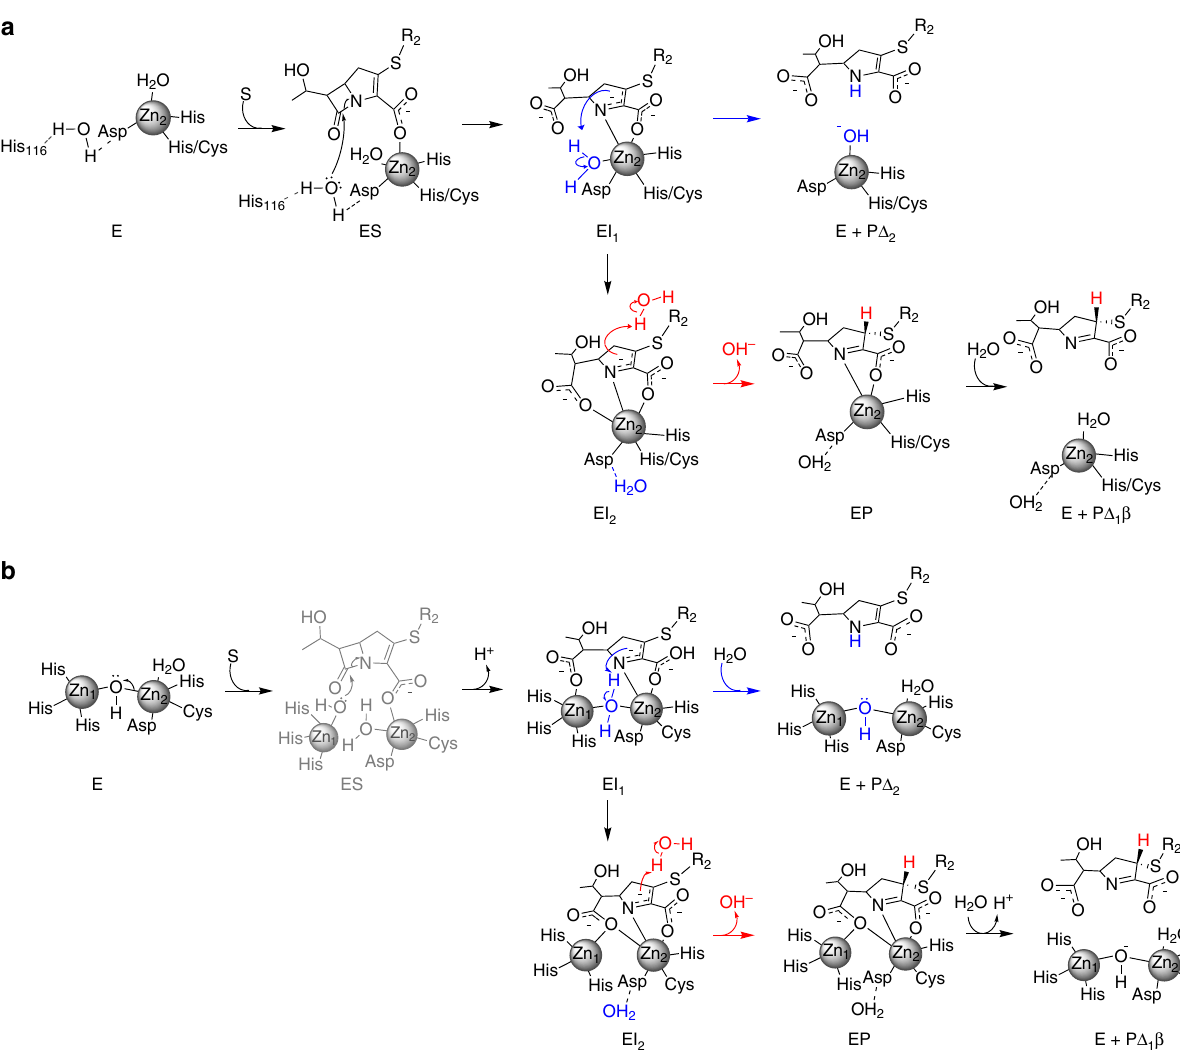
Fig. 7 Proposed mechanisms for carbapenem hydrolysis by M β Ls. a Proposed mechanism for mono-Zn(II)-M β Ls. b Proposed mechanism for bi-Zn(II)- M β Ls. The ES complex does not accumulate and is hence depicted in a lighter colour ( grey ). Its structure is proposed based on the ES detected for the mononuclear M β (12 scans per sample). The data were converted from energy to k-space using E0 = 9680 eV. The nonlinear least-squares engine of IFEFFIT was used to fi t Fourier- fi ltered EXAFS data. IFEFFIT is open source software available from http://www.cars9. uchicago.edu/ifef fi t, which is distributed with SixPack; which is available free of charge from http://www.sssrl.slac.stanfrd.edu/_swebb/index.html. Fourier- fi ltered EXAFS data were fi tted utilising theoretical amplitude and phase functions calculated with FEFF v.8.00 56 . The zinc – nitrogen and zinc – sulphur scale factors and the threshold energy, Δ E0, were held fi xed in all fi ts to the data for BcII, GOB, and Sfh-I samples (Zn – N Sc = 0.78, Zn – S Sc = 0.91, Δ E0 = − 21 eV, as described previously). First shell fi ts were fi rst obtained for all reasonable coordination numbers, including mixed nitrogen/oxygen/sulphur ligation, allowing only for variation of the absorber-scattered distances, Ras, and Debye − Waller factors, σ as2. Multiple scattering contributions from histidine ligands and metal – metal scattering were fi tted according to published procedures 55 .